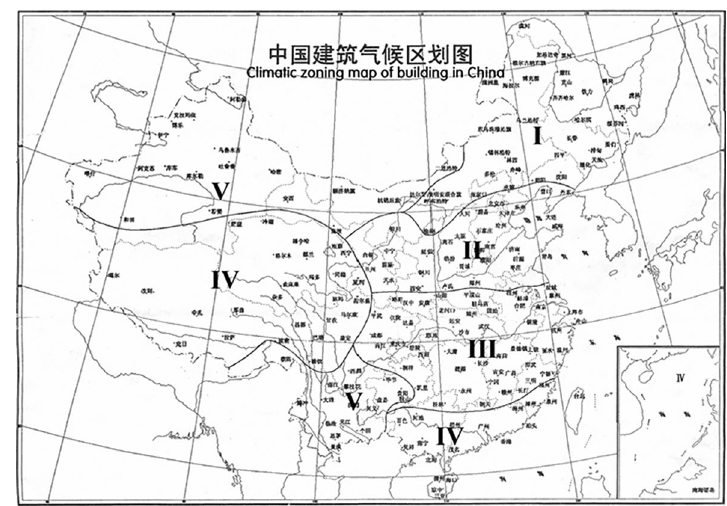
Figure 3. Climatic zoning map of buildings in China (source: Building Climate